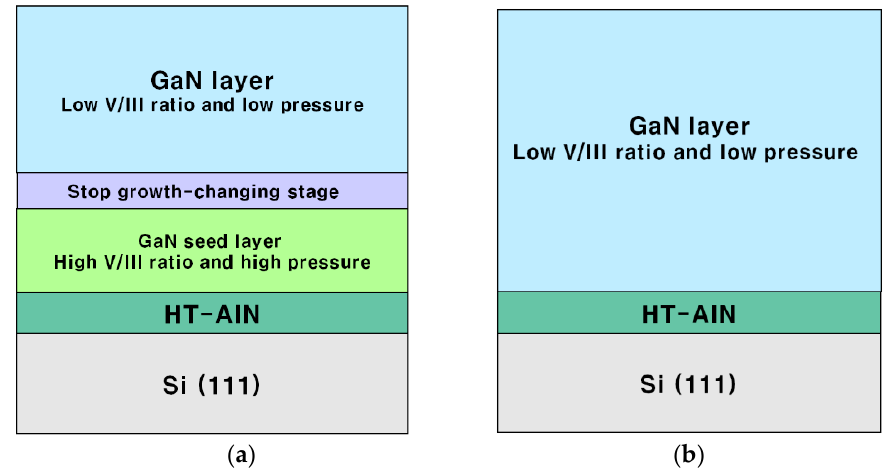
Figure 1. Schematic cross-sectional view of structure for GaN grown on Si substrate ( a ) with and ( b ) without two-step growth method.